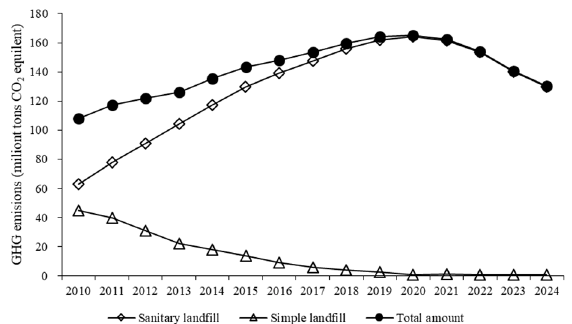
Figure 2. Quantity of GHG emissions from landfill